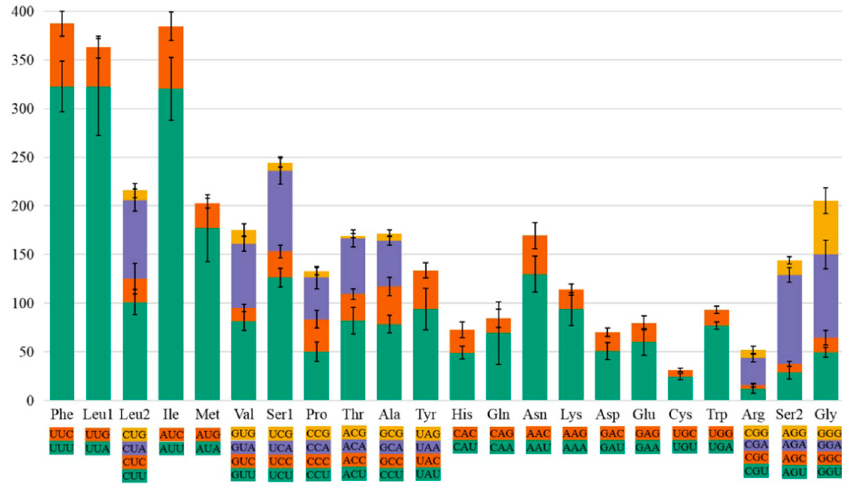
Figure 1. The use of amino acids of the protein-coding genes of the mitogenome in eight bark beetles. Codon families are indicated on the x-axis and amino acid numbers on the y-axis. The error bars represent the standard error.